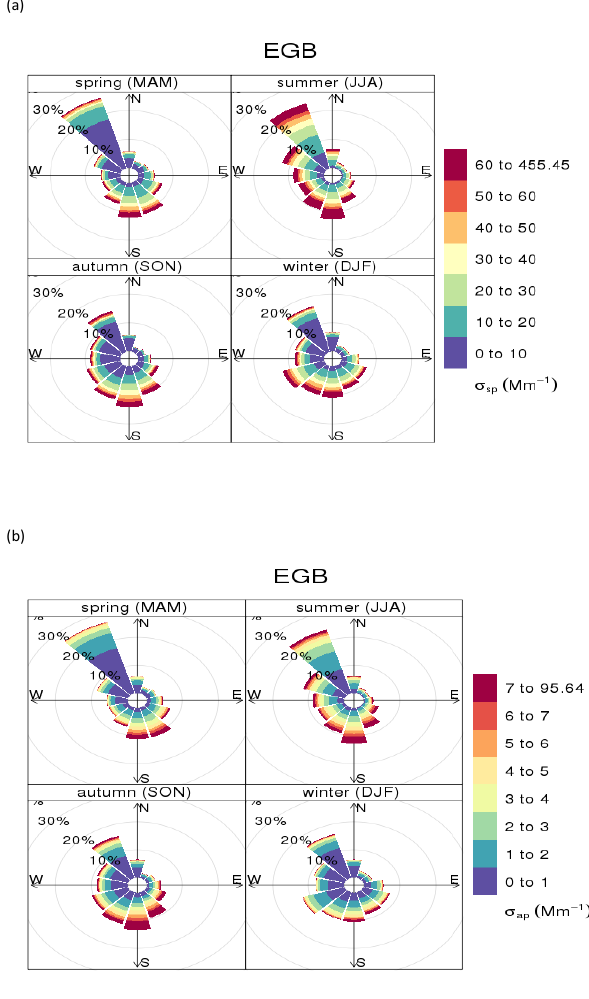
Figure 7. Pollution rose diagrams of PM 1 σ sp and σ ap for individual seasons at EGB over the 2010–2013 period. The percentages at a given radius represent the percentage of hourly profiles for a given wind